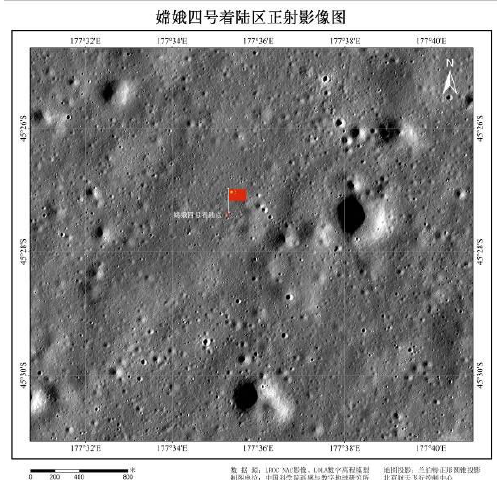
Figure 5. LROC NAC DOM of CE-4 landing site and lander location.